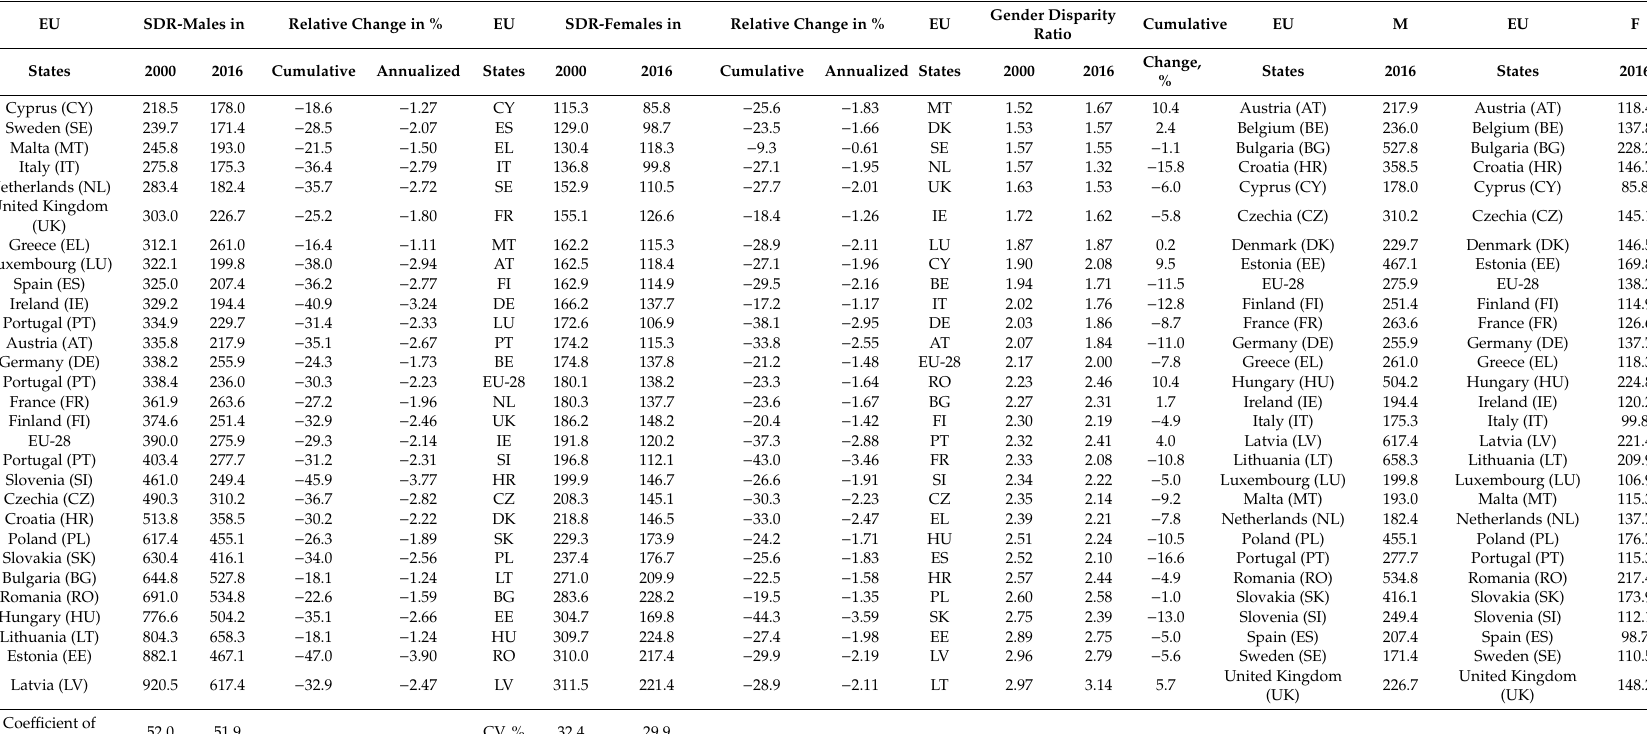
Table 1. Premature standardized death rates (SDR) in the EU countries in 2000 and 2016 (all causes of death) 1 .